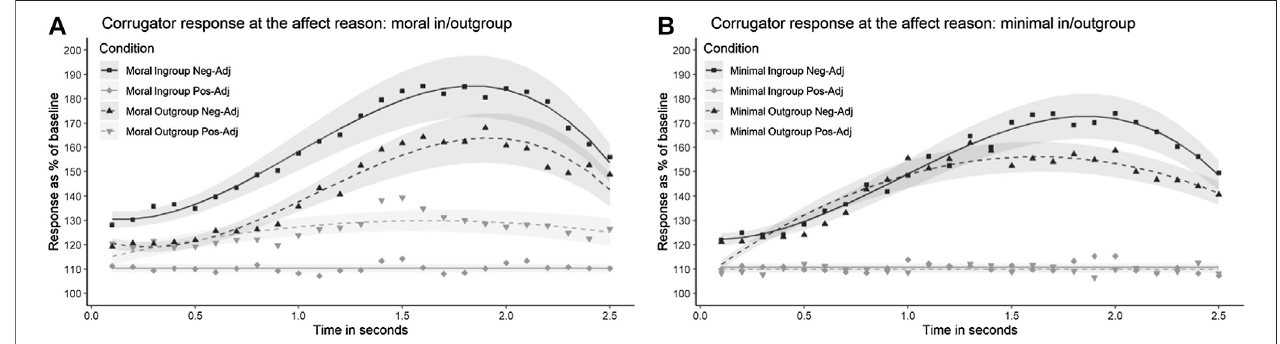
FIGURE 6 | Corrugator EMG response to reasons given for positive and negative character affect, for (A) moral and (B) minimal in- and outgroups. Dots show the observed data (averaged per 100 ms), and lines show the fi nal growth curve model. The gray bands represent 95% con fi dence intervals from the fi nal growth curve